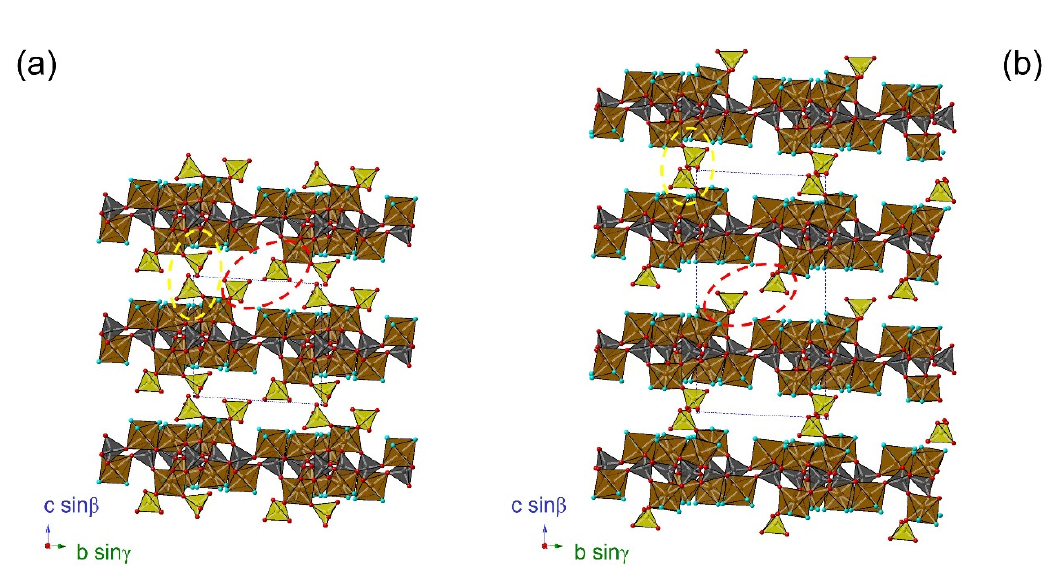
Figure 2. Comparison between the c ~ 10.8 Å ( a ) and c ~ 21.6 Å ( b ) crystal structure of bohuslavite, seen down a . Brown, dark grey, and yellow polyhedra are Fe-, P-, and S-centered. Red and light blue circles represent O 2- and [H 2 O,(OH) - ] groups. Interlayer H 2 O groups are not shown. Iron is hosted in octahedral coordination. Average bond distances range between 1.96 and 2.01 Å, with values varying between 1.84 and 2.22 Å; the observed average distances are in keeping with the ideal <Fe 3+ –O> distance of 2.015 Å, calculated using the bond parameters of Brese and O’Keeffe [14]. In the structural model of Mauro et al. [9], such average bond distances were slightly shorter, ranging between 1.94 and 1.99 Å. As a consequence, the BVS of the Fe atoms was higher than the theoretical values, varying between 3.21 and 3.66 valence units (v.u.). This overbonding is less pronounced in the new crystal structure refinement, with values ranging between 3.06 and 3.54 v.u., with an average value of 3.23 v.u. The deviations from the ideal value are probably related